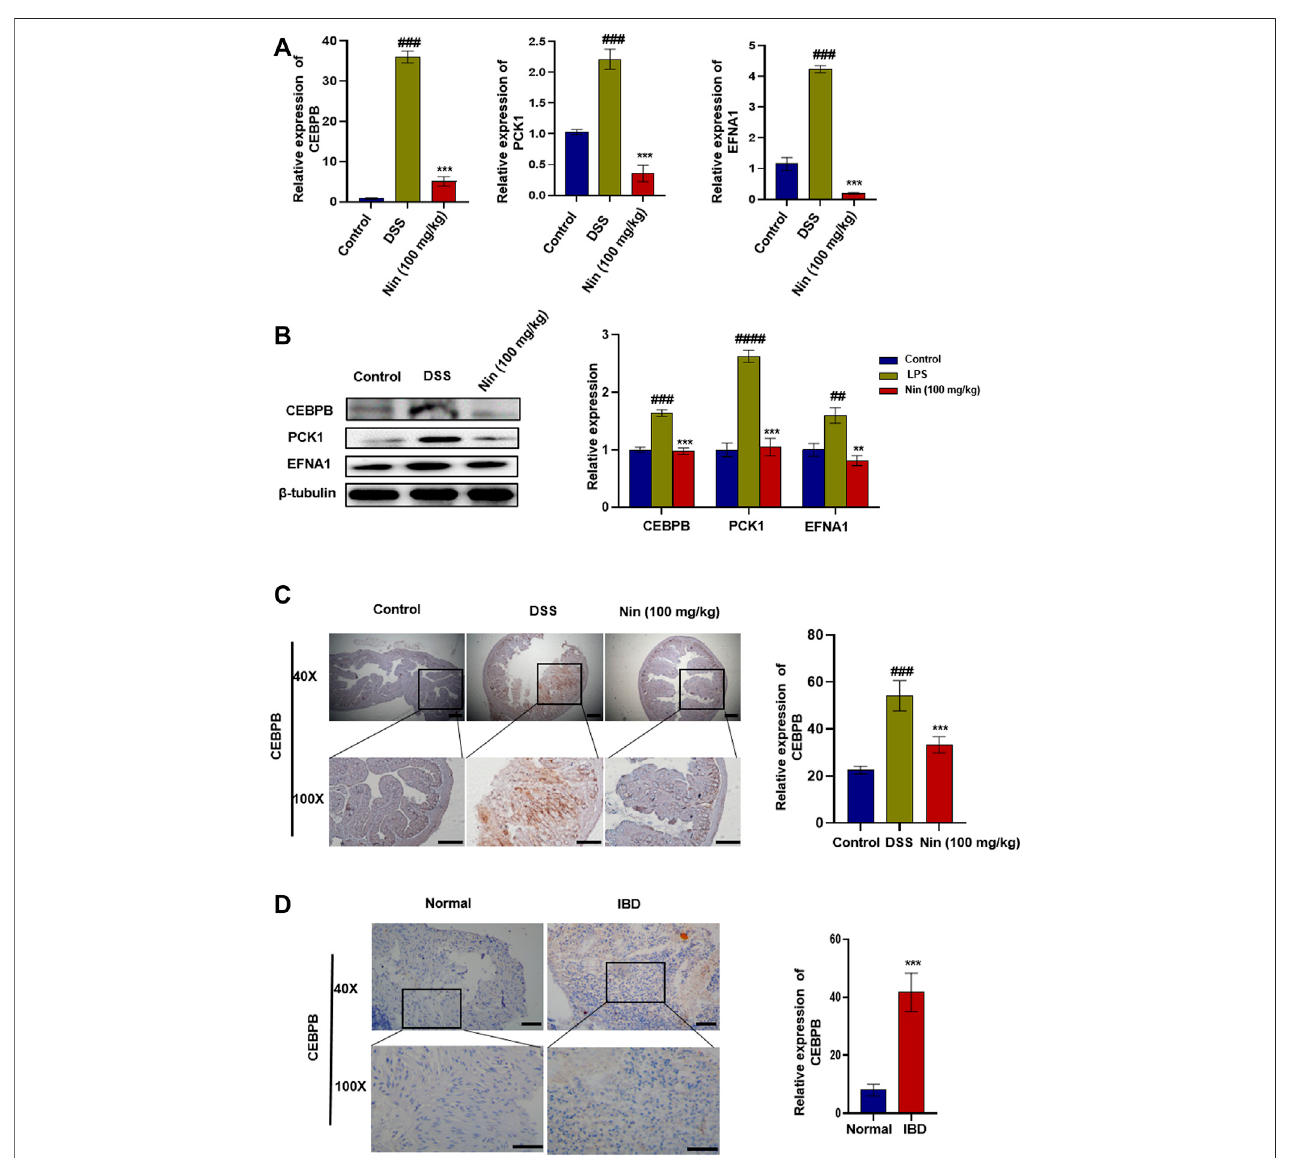
FIGURE 5 | Inhibition of CEBPB/PCK1 and CEBPB/EFNA1 pathways by nintedanib in vivo . (A) Effect of nintedanib on the level of CEBPB, PCK1, and EFNA1 mRNA in the colon tissue. (B) Effect of nintedanib on the expression of CEBPB, PCK1, and EFNA1 proteins in the colon tissue. The IHC staining analysis of CEBPB in mouse (C) and human (D) colon tissues. Scale bars represent 50 μ m. Data are presented as the mean ± SD ( n = 5). # p < 0.05, ## p < 0.01, ### p < 0.001 and #### p < 0.0001, signi fi cantly different from the control group; *p < 0.05, **p < 0.01, ***p < 0.001 and ****p < 0.0001, signi fi cantly different from DSS groups.